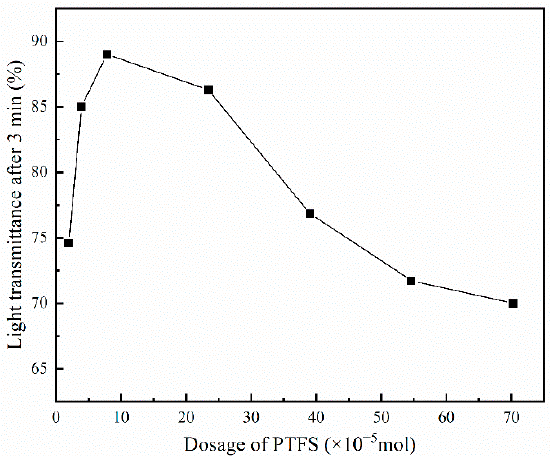
Figure 1. Sedimentation effect of using PTFS (Ti:Fe = 1:7) alone .